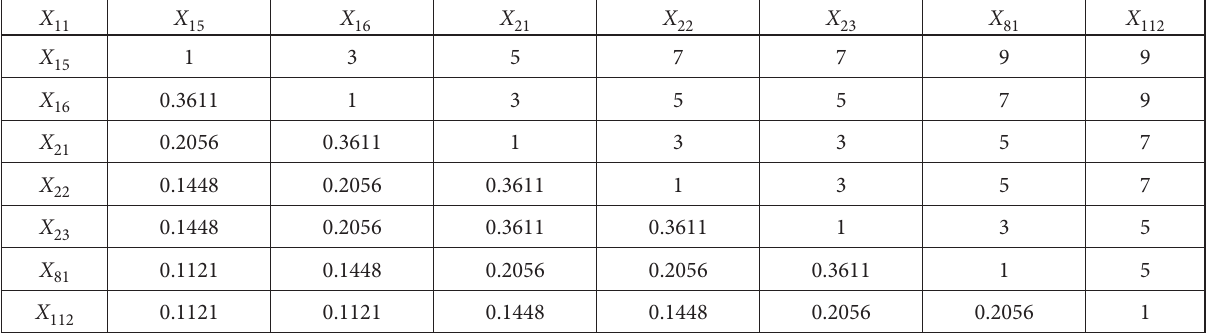
Table 8. Pair-wise comparison with crisp